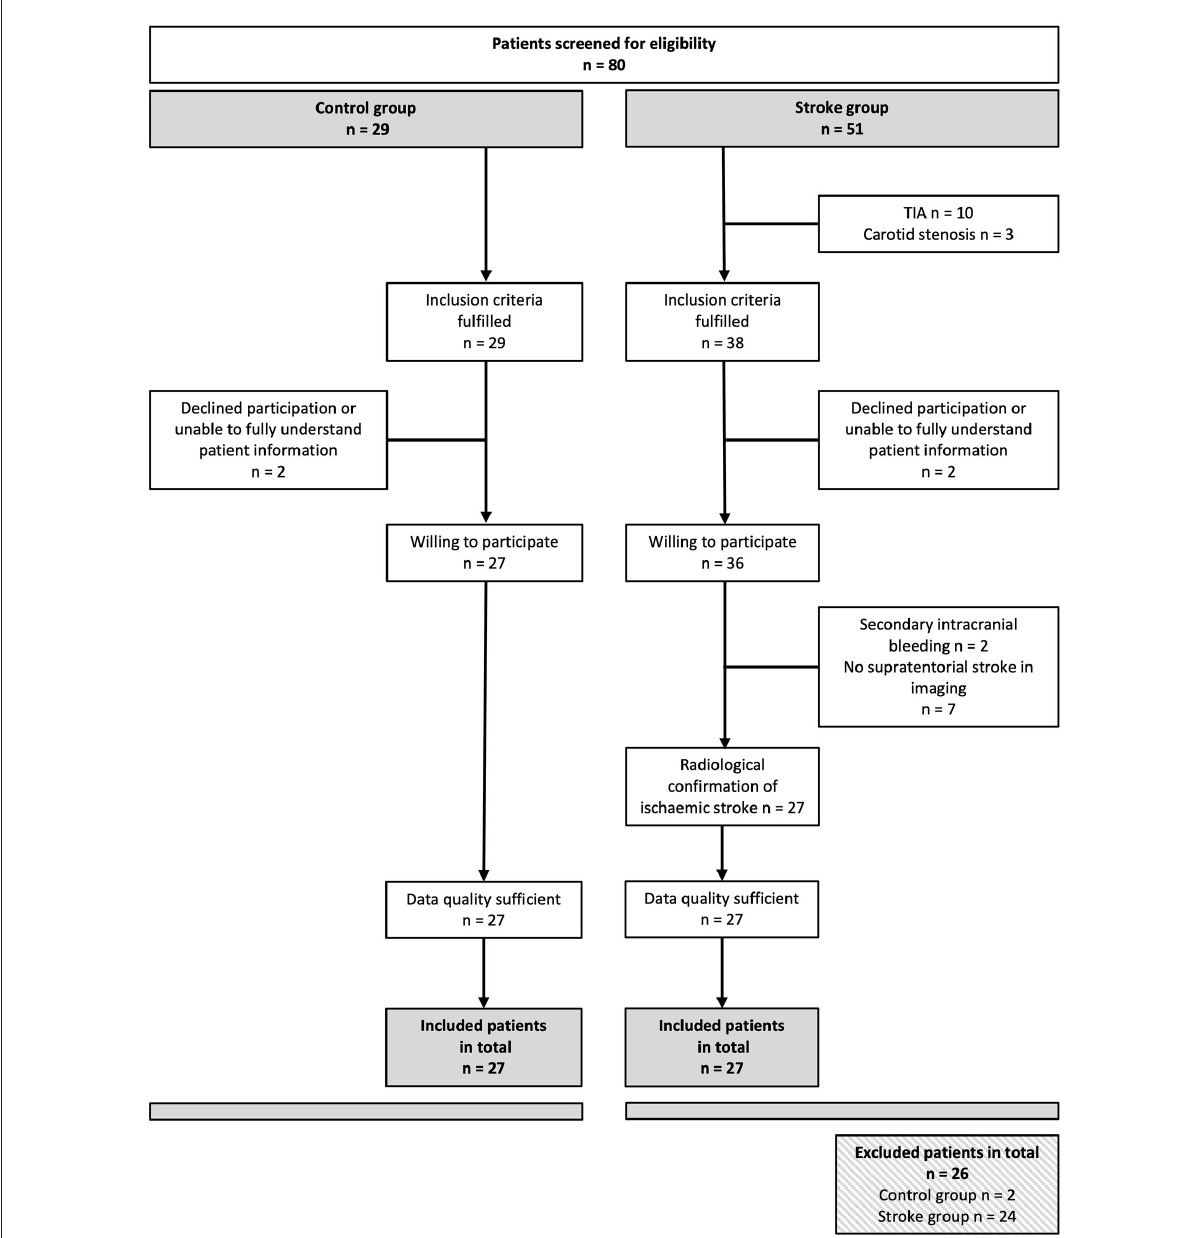
FIGURE1 Flow chart of the recruitment of subjects. Of 80 patients initially screened, 54 could be included in the study. Both the control group and the stroke group included 27 people each.